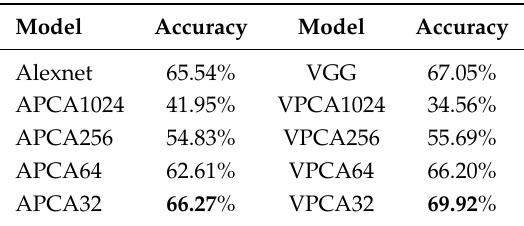
Table 12. Retrieval accuracies of the different dimensional features obtained using the DPCA method according to the P@150 values.